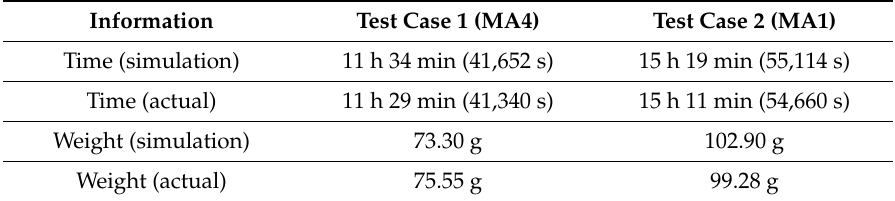
Table 2. Observations from the test cases for time and weight of the build.